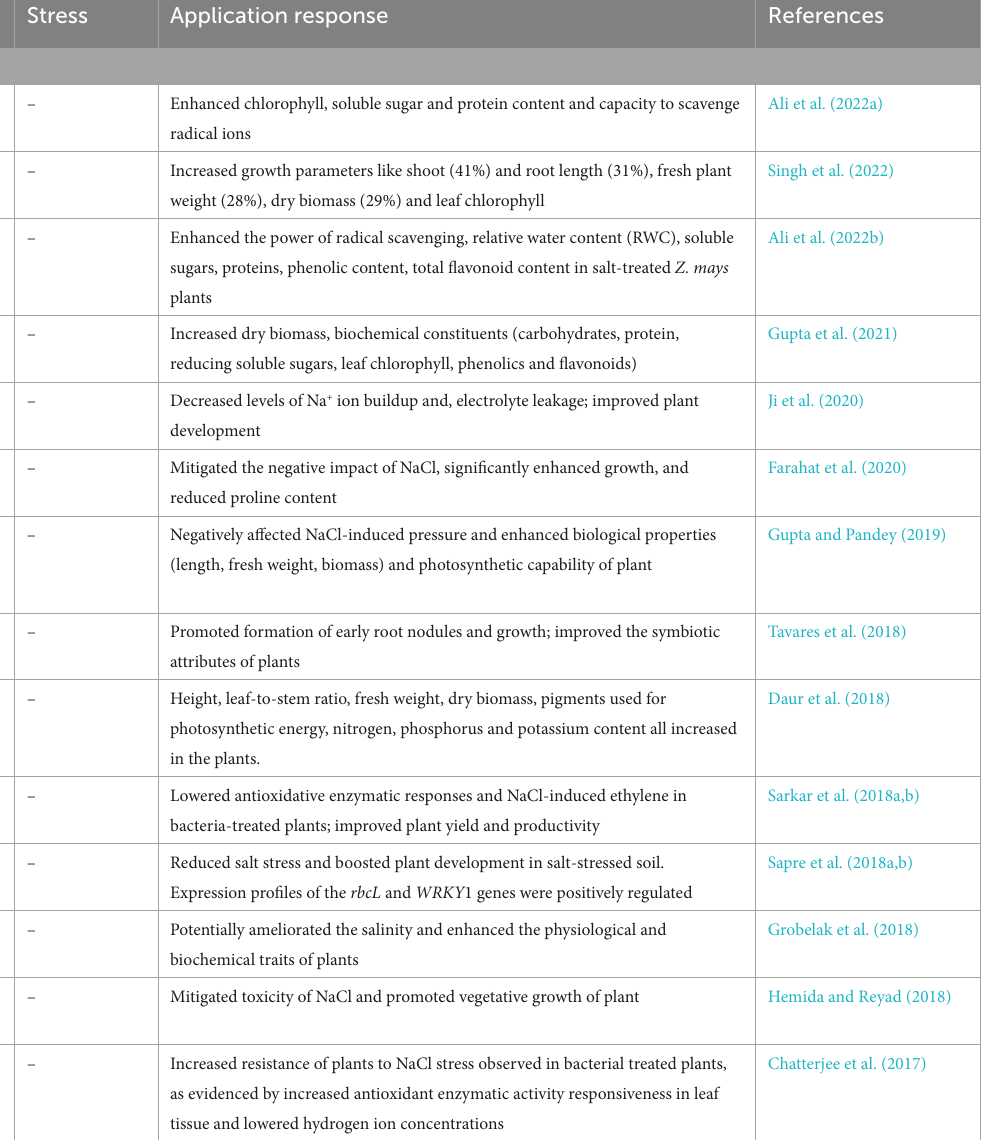
TABLE 2 Selected examples of ACCD synthesizing PGPR strains in alleviation of abiotic and biotic stress. S.